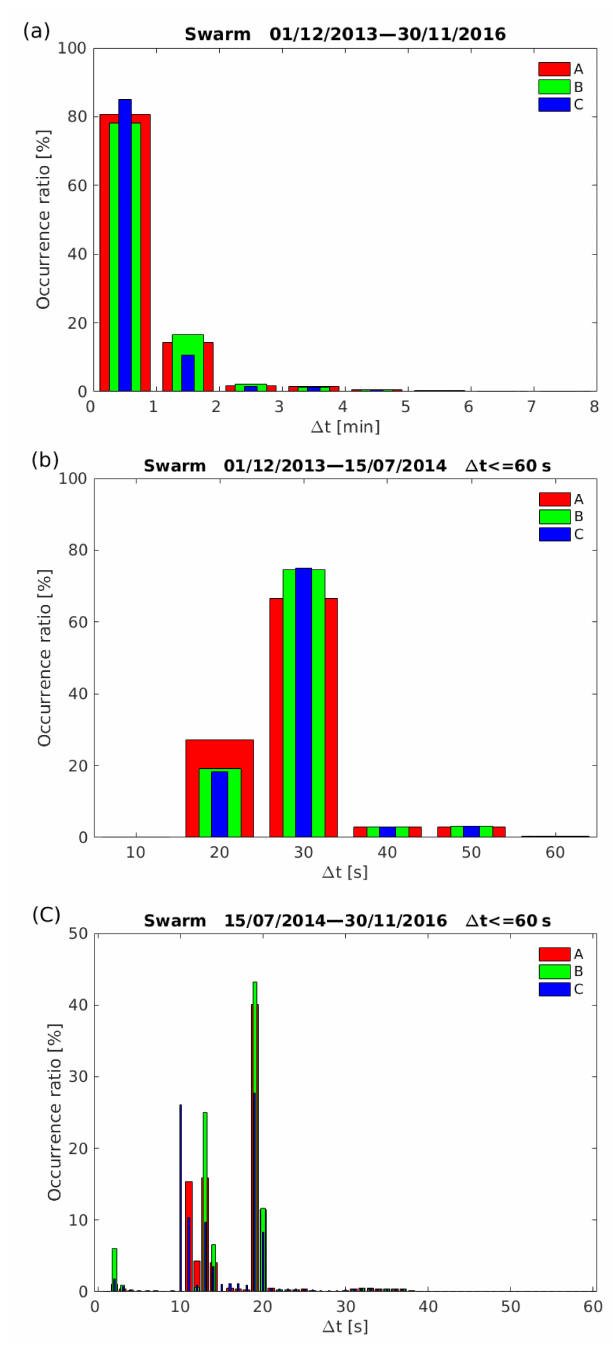
Figure 1. (a) The occurrence ratio of the duration ( (cid:49)t ) for GPS sig- nal loss events observed by the three Swarm satellites. The detailed occurrence ratio of events with (cid:49)t < 1min during the two periods are shown. The RINEX records time resolutions are (b) 10s and (c) 1s.